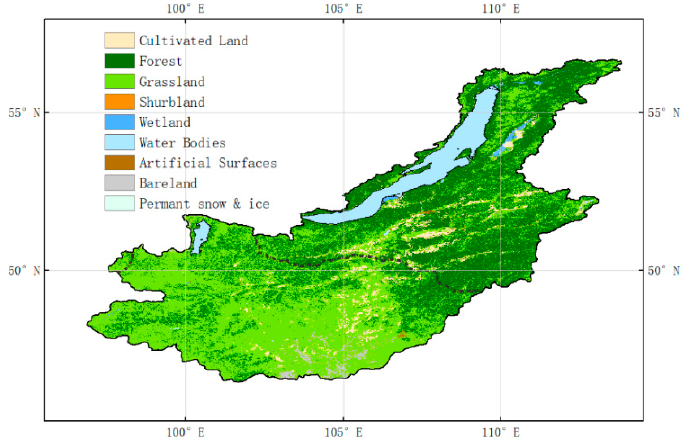
Figure 5. Spatial distribution of the different vegetation types in the Selenga-Baikal Basin based on GlobeLand30 in 2010.